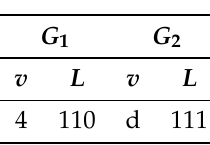
Table 1. Labels ( L ) on the non-mapped vertices ( v ) of G 1 and G 2 . a M = { 1, a